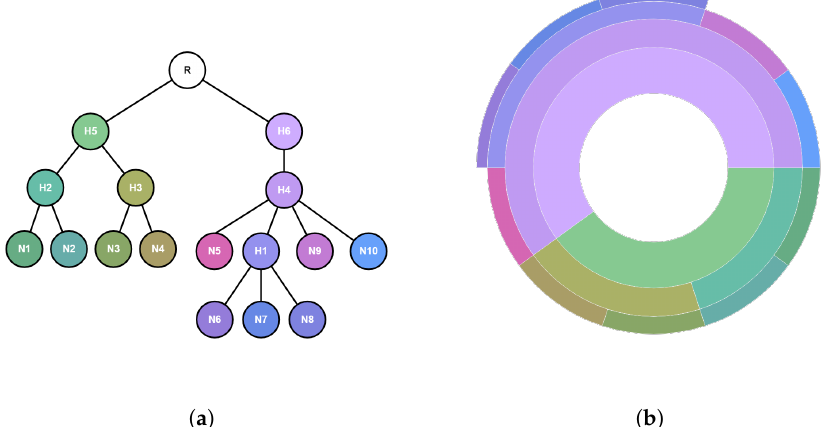
Figure 1. ( a ) Classic node-link representation of a simple tree. ( b ) The same tree depicted using a sunburst diagram.